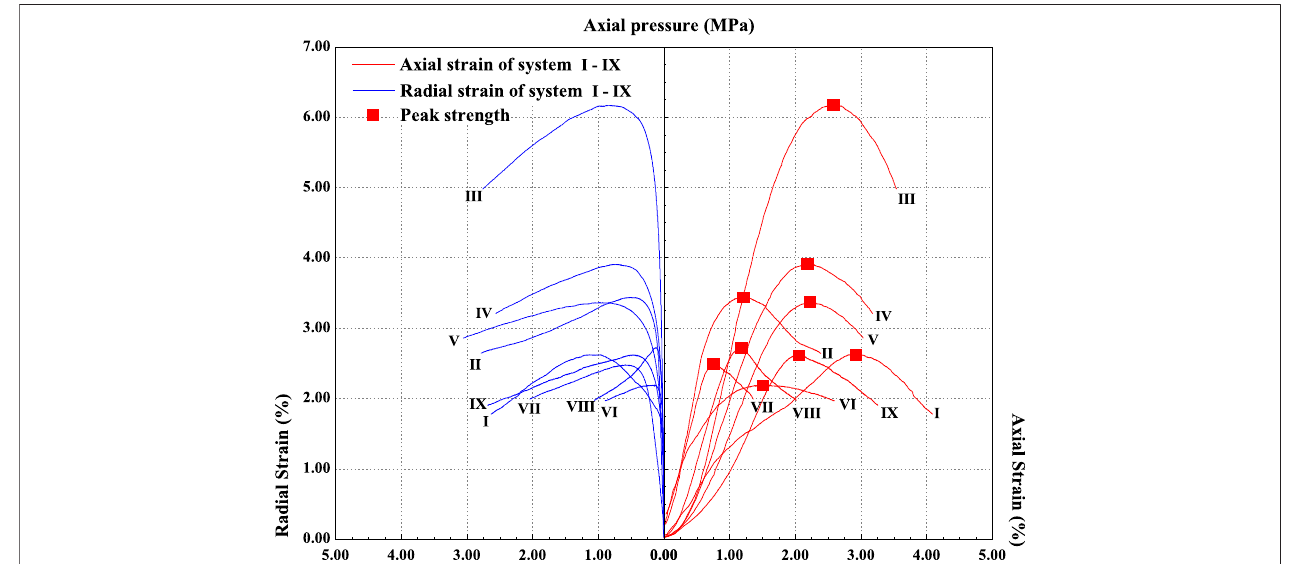
FIGURE 6 | Stress – strain curves of cemented coal bodies under orthogonal experimental system.